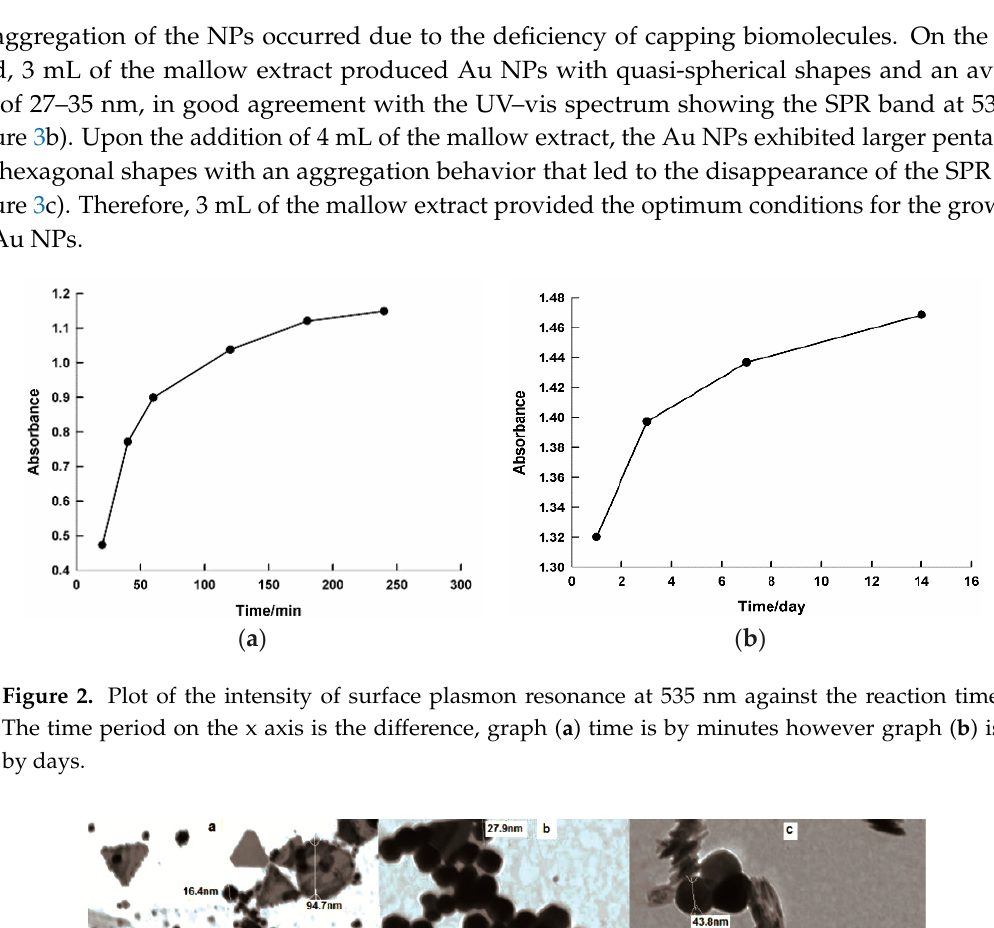
Figure 3. Transmission electron microscopy (TEM) images of Au NPs in the presence of different volumes of the broth extract: ( a ) 2 mL, ( b ) 3 mL, and ( c ) 4 mL.